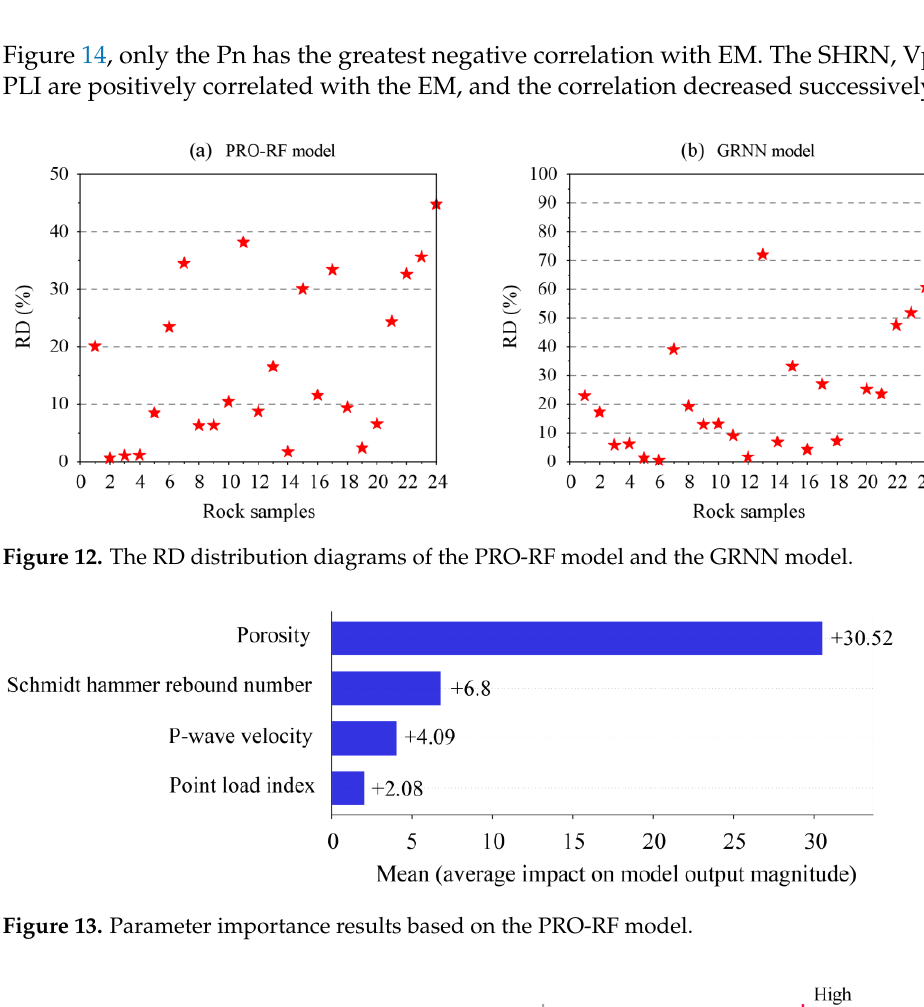
16 of 20 Figure 11. Intuitive comparison diagram of the measured EM and predicted EM by the proposed models: (a) PRO-RF model; (b) GRNN model. Table 6. Error analysis comparison between the PRO-RF model and the GRNN model. Models